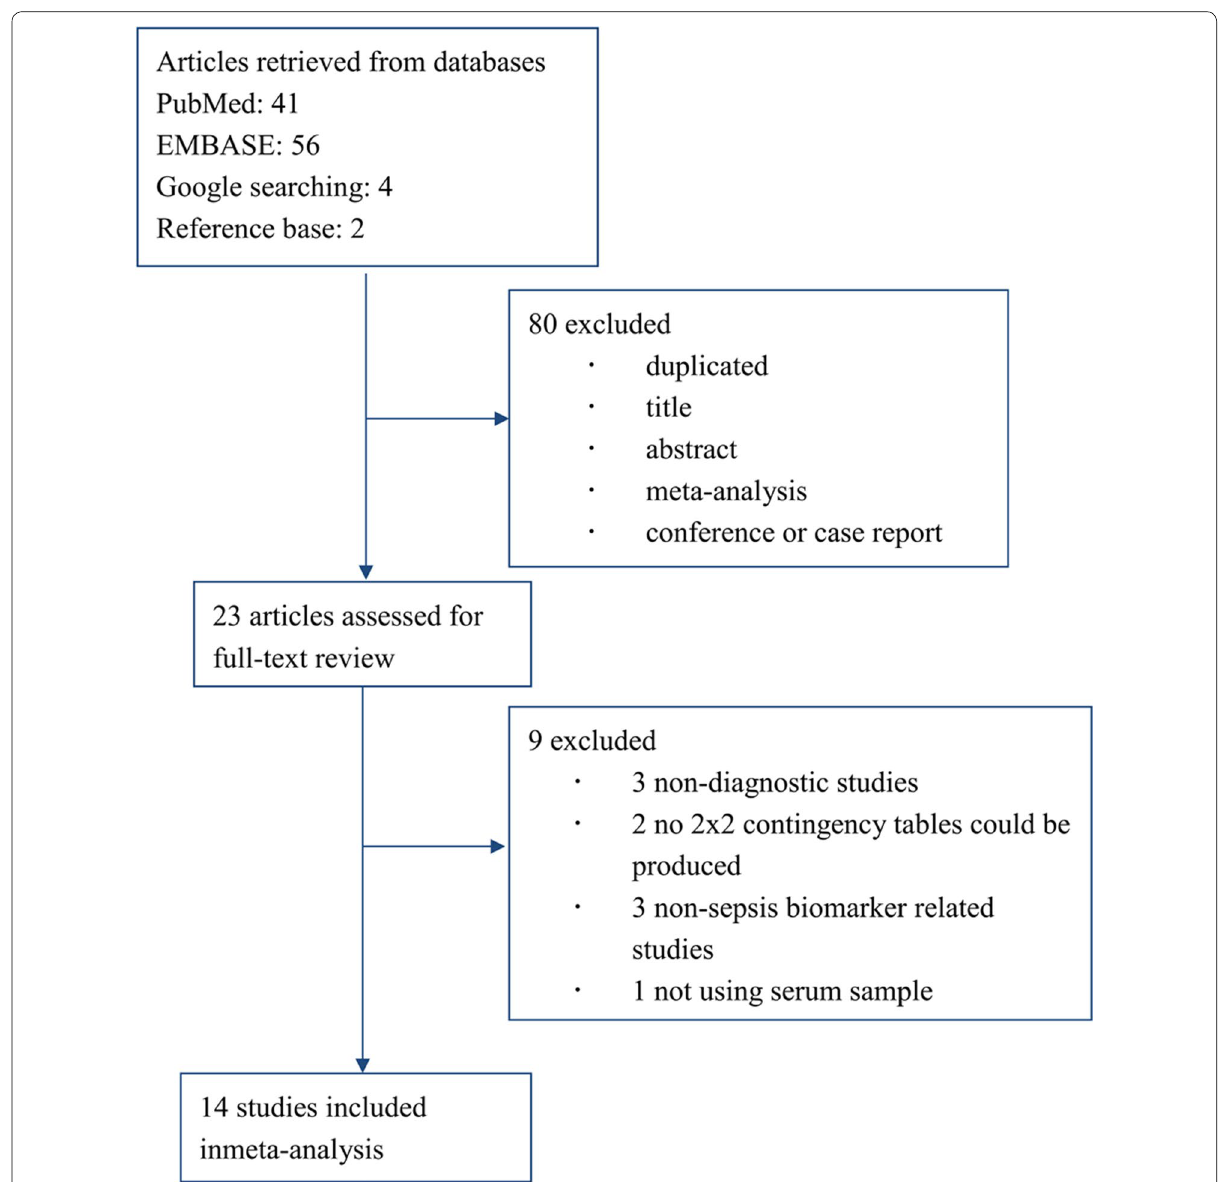
Fig. 1 Flowchart of study selection, inclusion, and exclusion for the meta‑analysis of CD64 for diagnosis of